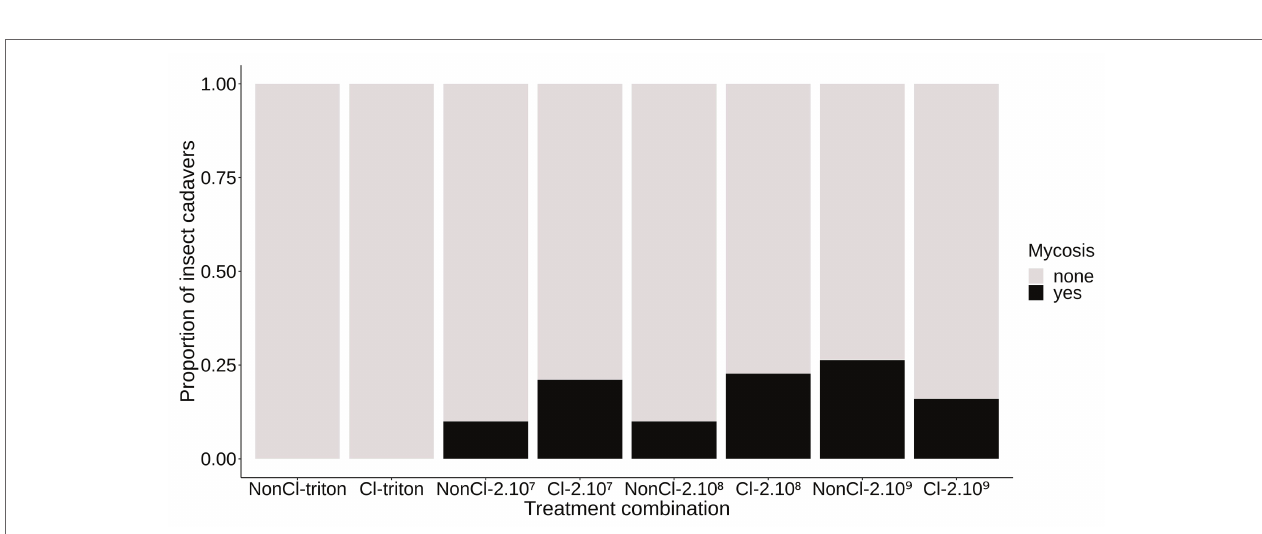
FIGURE 2 | Mycelial colonization of the cadavers of A. rosae . Stacked bar graph representing the proportion of A. rosae cadavers showing mycelial colonization, i.e., mycosis (yes) or not (none) by B. bassiana KVL 03-122 depending on the inoculation and exposure treatments: Non-Cl, no clerodanoids exposure, Cl, clerodanoids exposure; triton, 2.10 7 , 2.10 8 , and 2.10 9 represent the inoculation control and the inoculum concentration in conidial/ml. Neither the inoculation nor the clerodanoids exposure treatments significantly affected the proportion of cadavers showing mycelial